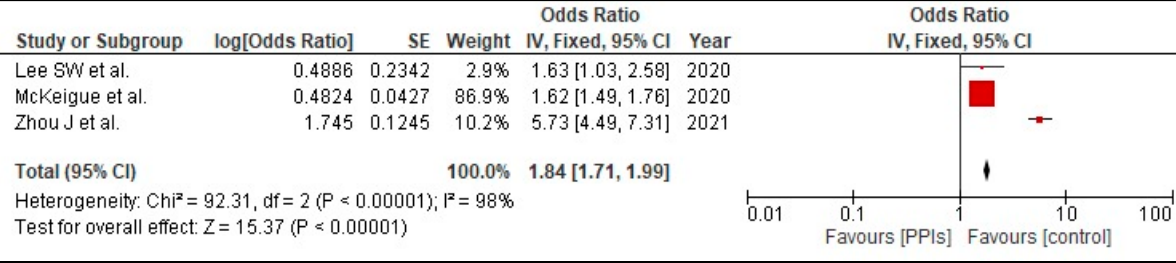
Figure 3. Risk of poor composite outcome in patients with COVID-19 on PPI versus not on PPI.